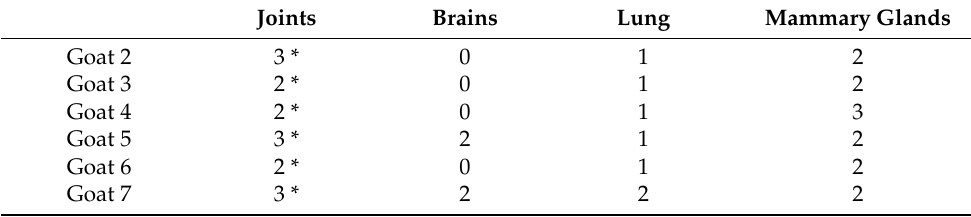
Table 1. Inflammation intensity scored in histopathological sections from the examined goats. Joints Brains Lung Mammary Glands Goat 2 3